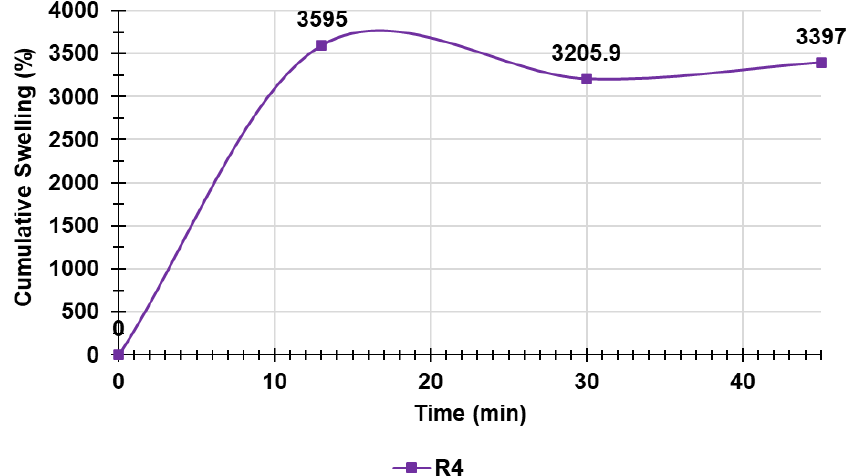
Figure 8. Cumulative swelling ratio percentage curve of R4.